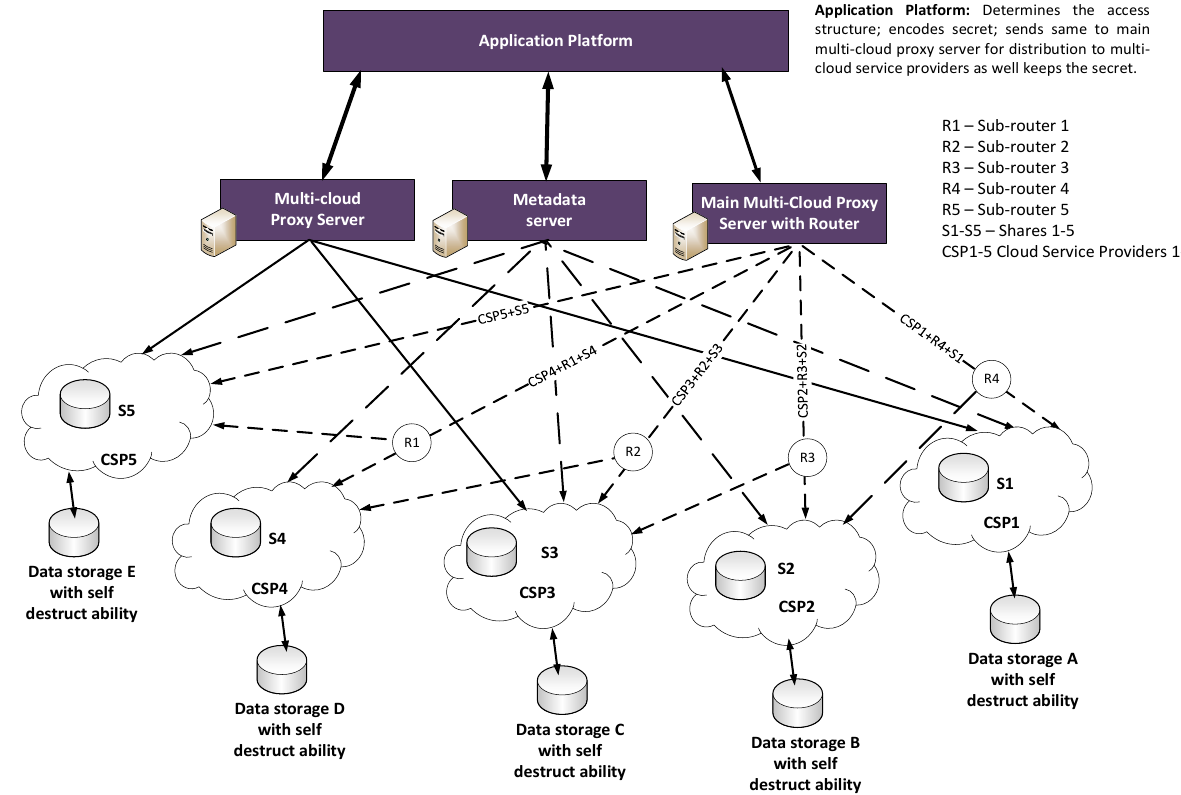
Figure 2. Proposed architecture of a Secret Sharing Scheme in a Multi-cloud